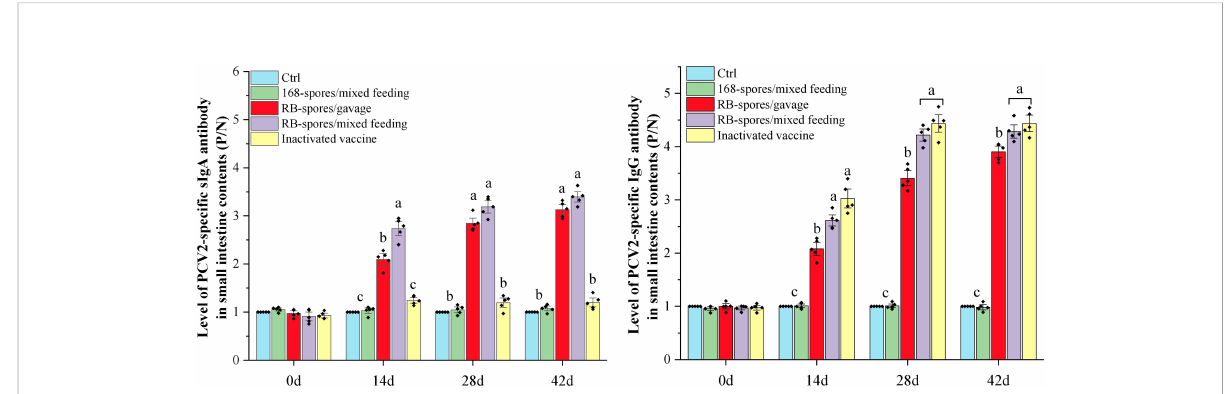
FIGURE 4 Immune responses after immunizing mice with different methods. The levels of sIgA in the small intestinal contents and IgG levels in serum of experimental mice at 0d, 14d, 28d, and 42d were expressed as P/N values. Data were presented as mean ± standard deviation ( n =5). One-way ANOVA followed by a Friedman test was performed, bars with different letters indicate signi fi cant difference ( P <